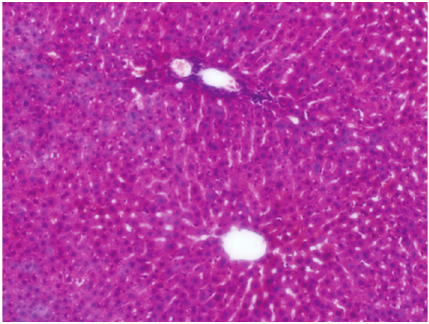
Figure 13: Slightly hepatic steatosis in the liver of a rat in the AOM